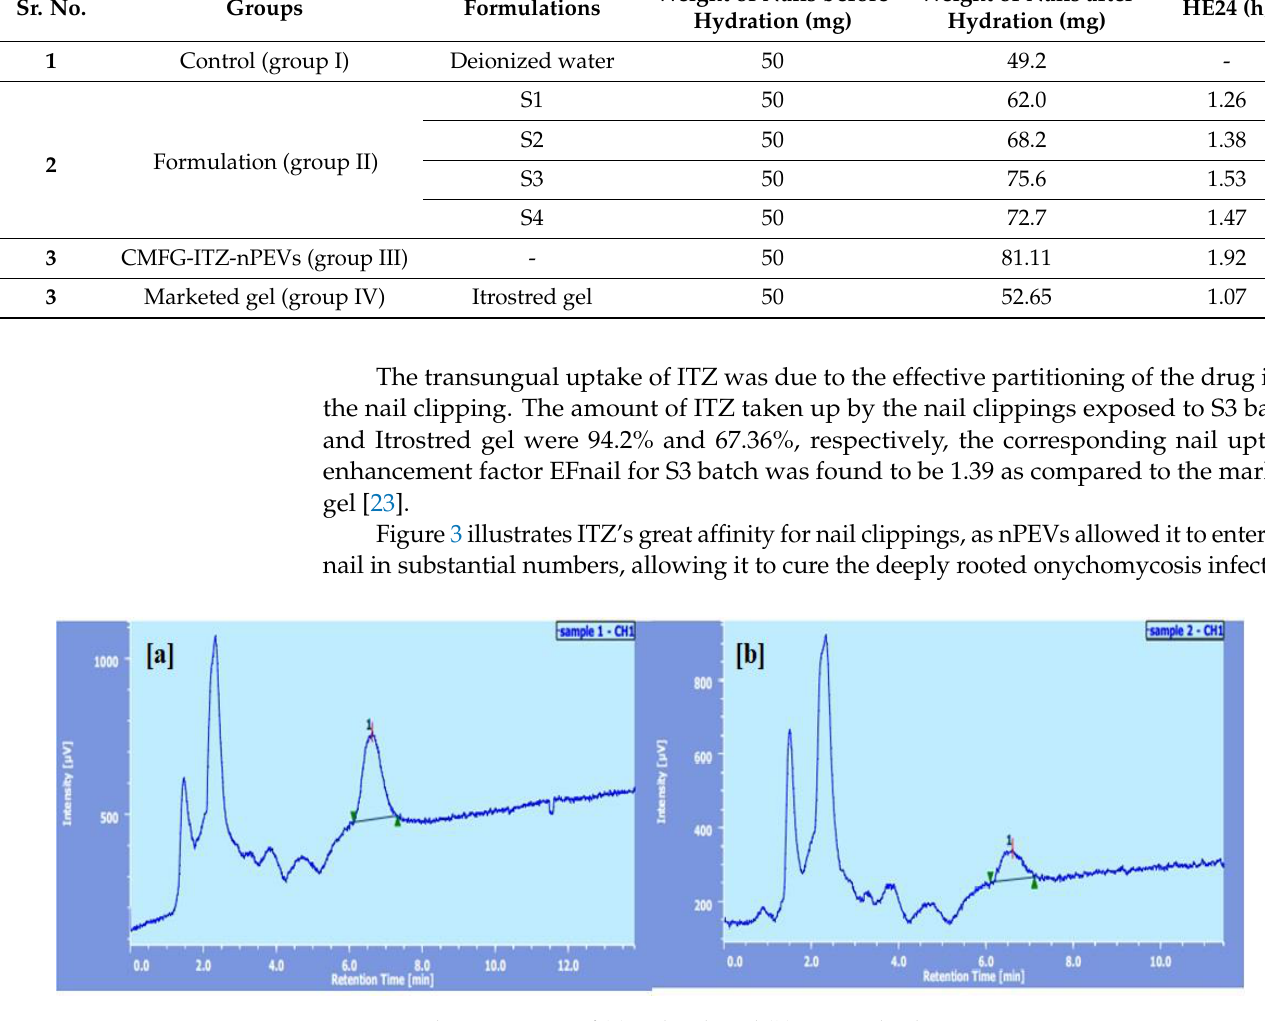
Figure 3. Chromatogram of ( a ) S3 batch and ( b ) Itrostred gel.